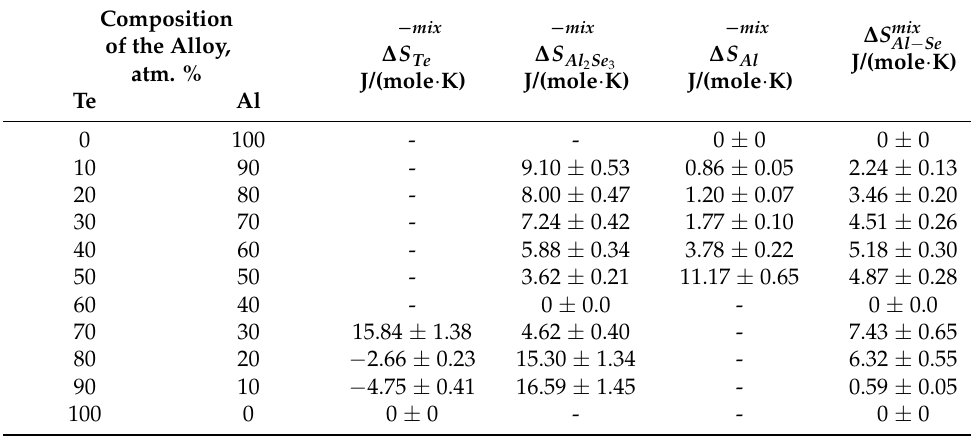
Table 5. Change of partial and integral mixing enthalpy of Al-Te system. Composition of the Alloy, atm. % ∆ Al